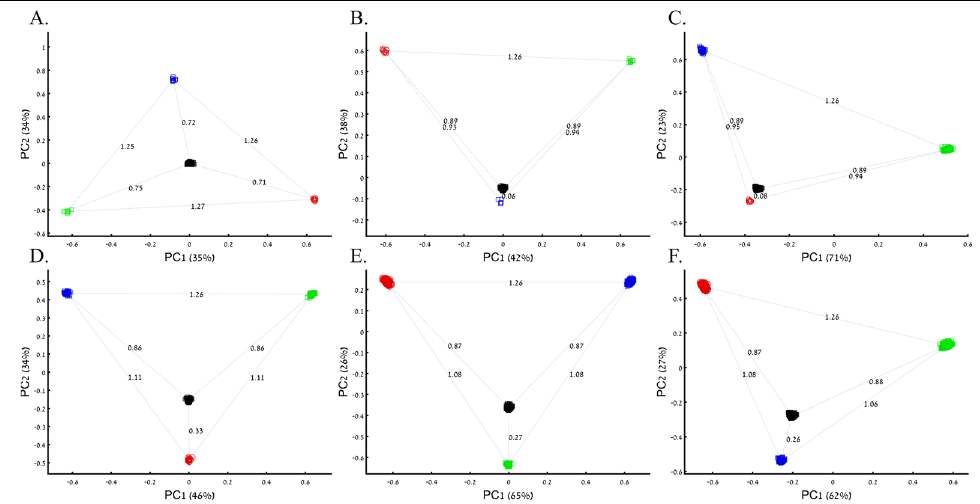
Figure 4. PCA of uneven-sized samples of four color populations. ( A ) n Red = n Green = n Blue = 10; n Black = 200, ( B ) n Red = n Green = 10; n Blue = 5; n Black = 200, ( C ) n Red = 10; n Green = 200; n Blue = 50; n Black = 200 ( D ) n Red = 25; n Green = n Blue = 50; n Black = 200, ( E ) n Red = 300; n Green = 200; n Blue = n Black = 300, and ( F ) n Red = 1000; n Green = 2000; n Blue = 300; n Black = 2000. Scatter plots show the top two PCs. The numbers on the grey bars reflect the Euclidean distances between the color populations over all PCs. Colors include Red [1,0,0], Green [0,1,0], Blue [0,0,1], and Black